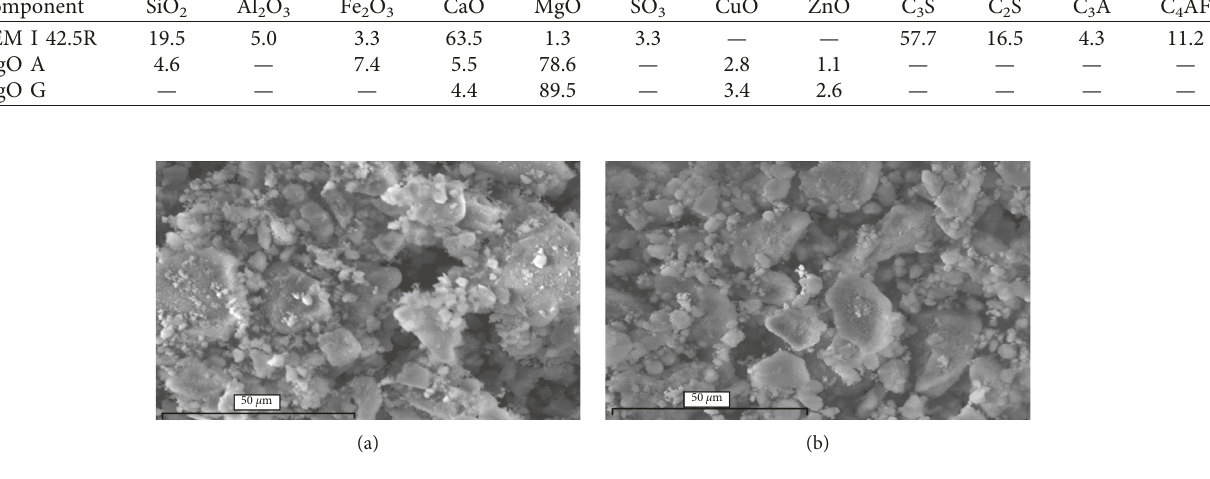
Figure 1: SEM micrographs of (a) MgO A and (b) MgO G.